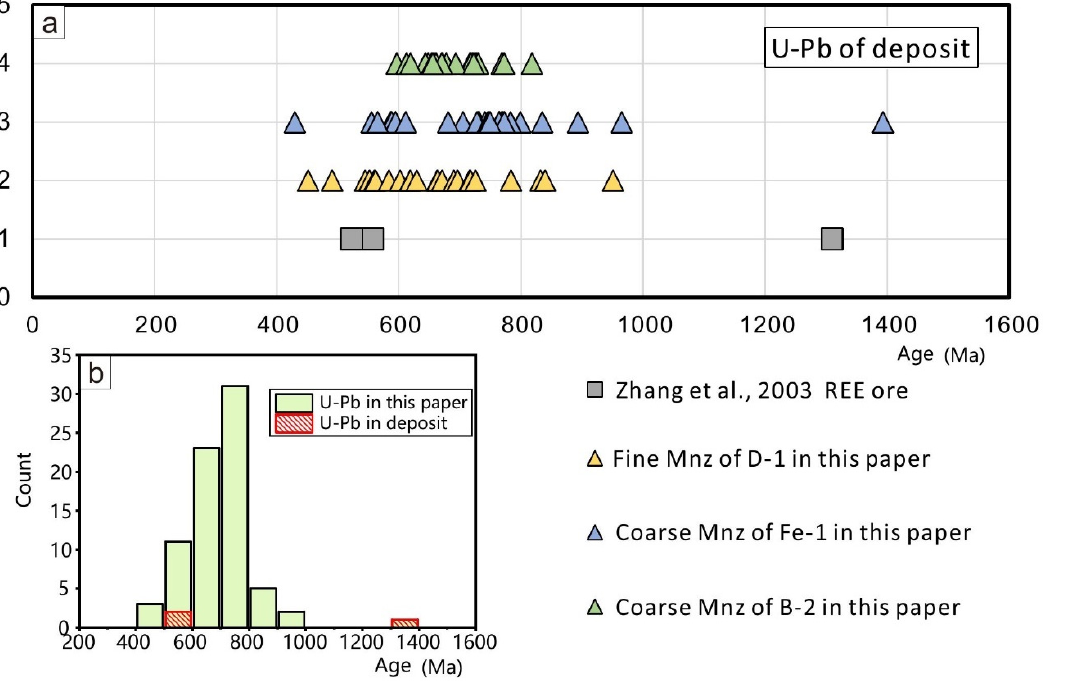
Figure 18. Age distribution characteristics of U–Pb in the ore deposit. ( a ) Single age distribution characteristics corresponding to different studies. ( b ) Stack histograms of all ages. [34].